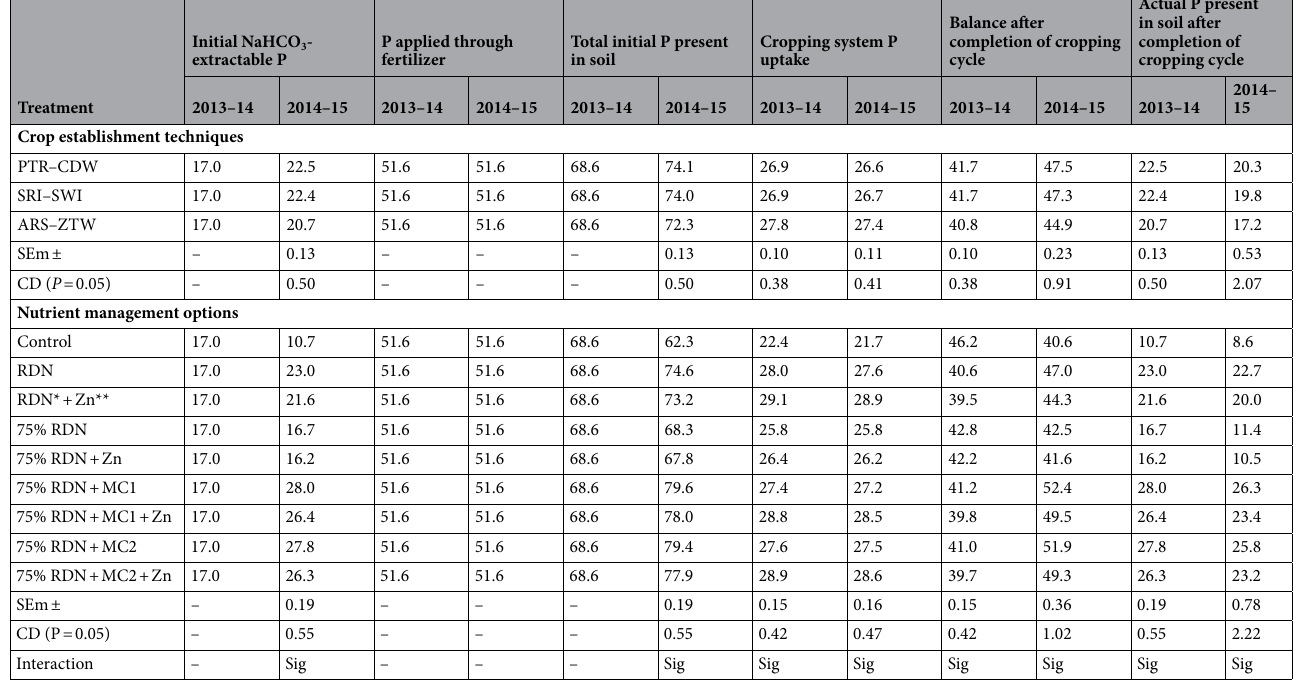
Table 11. Effect of crop establishment techniques and nutrient management options on phosphorus (P)